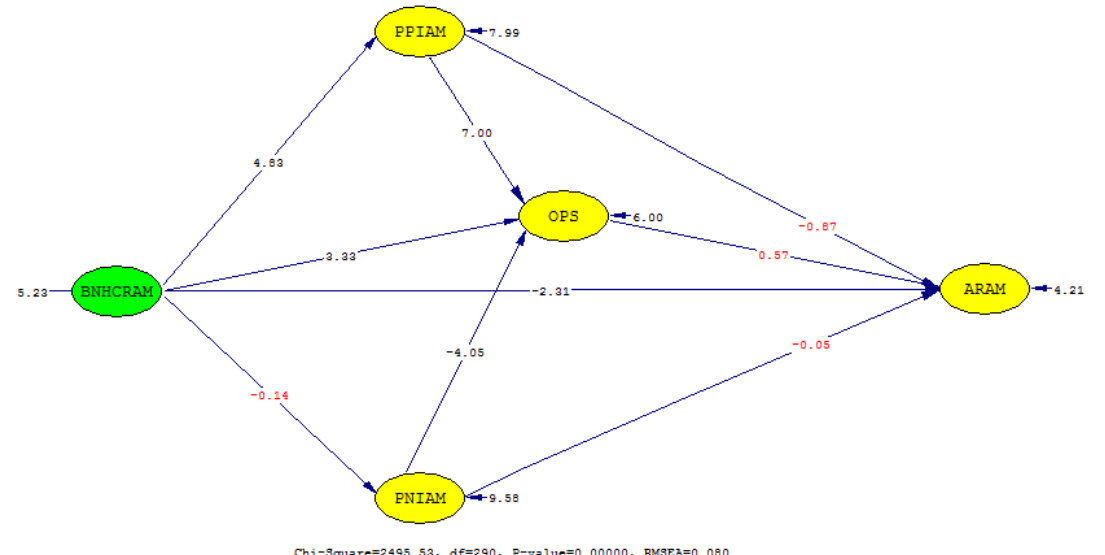
Figure 2. The t -values of the relationships in the structural model. The values appearing in red are non-significant. The latent constructs are in an oval shape while the arrow from one latent construct to another indicates the direction of the relationship. Table 3. Parameter estimates and direction of the relationships in the structural model. No. Path Standardized Estimate Standard Error